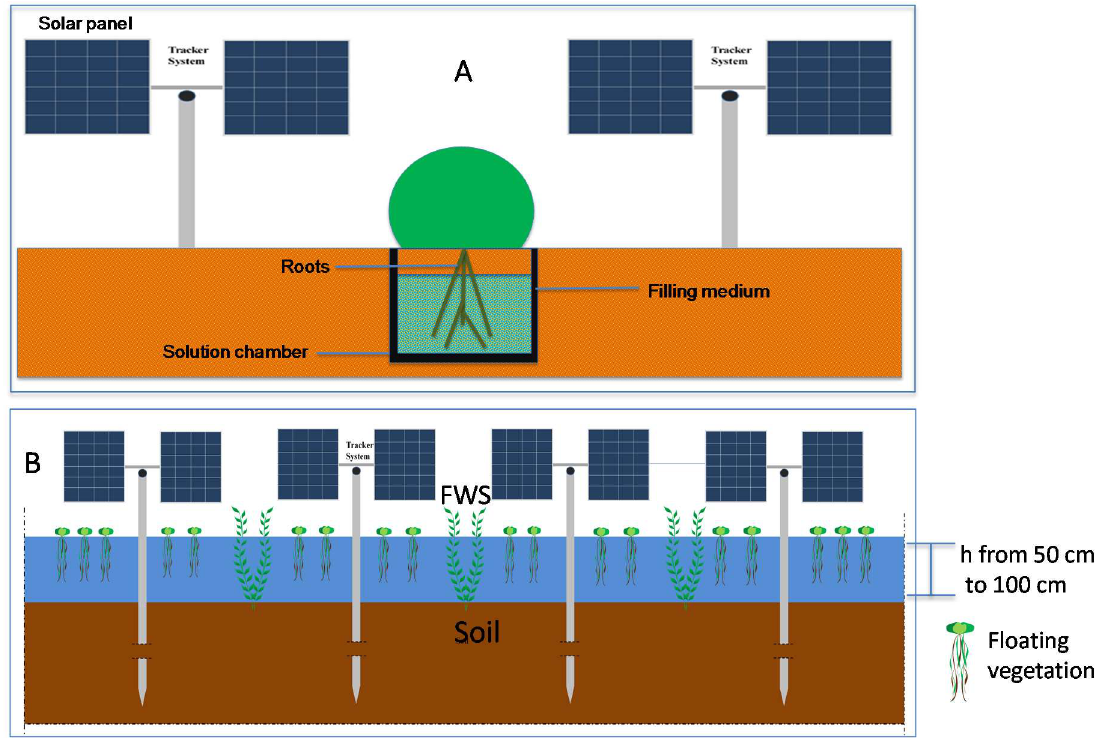
Figure 7. ( a ) Example of solution for the SFS with the vegetation located between the panel rows in one type of the GPV systems analysed; ( b ) schematisation of an example section related to the GPV system integrated with the FWS system, with potential reuse of treated water.